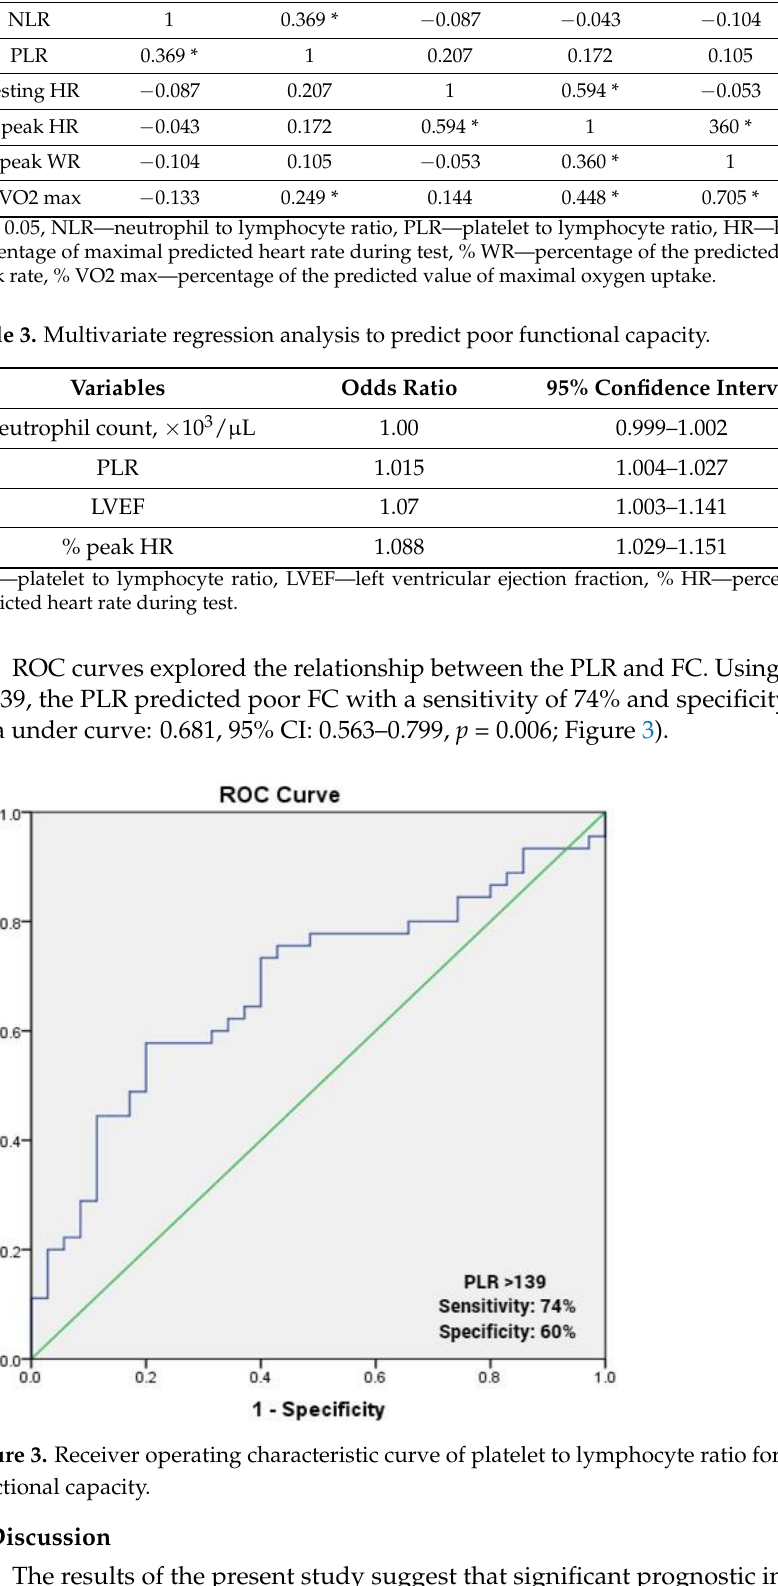
functional capacity.